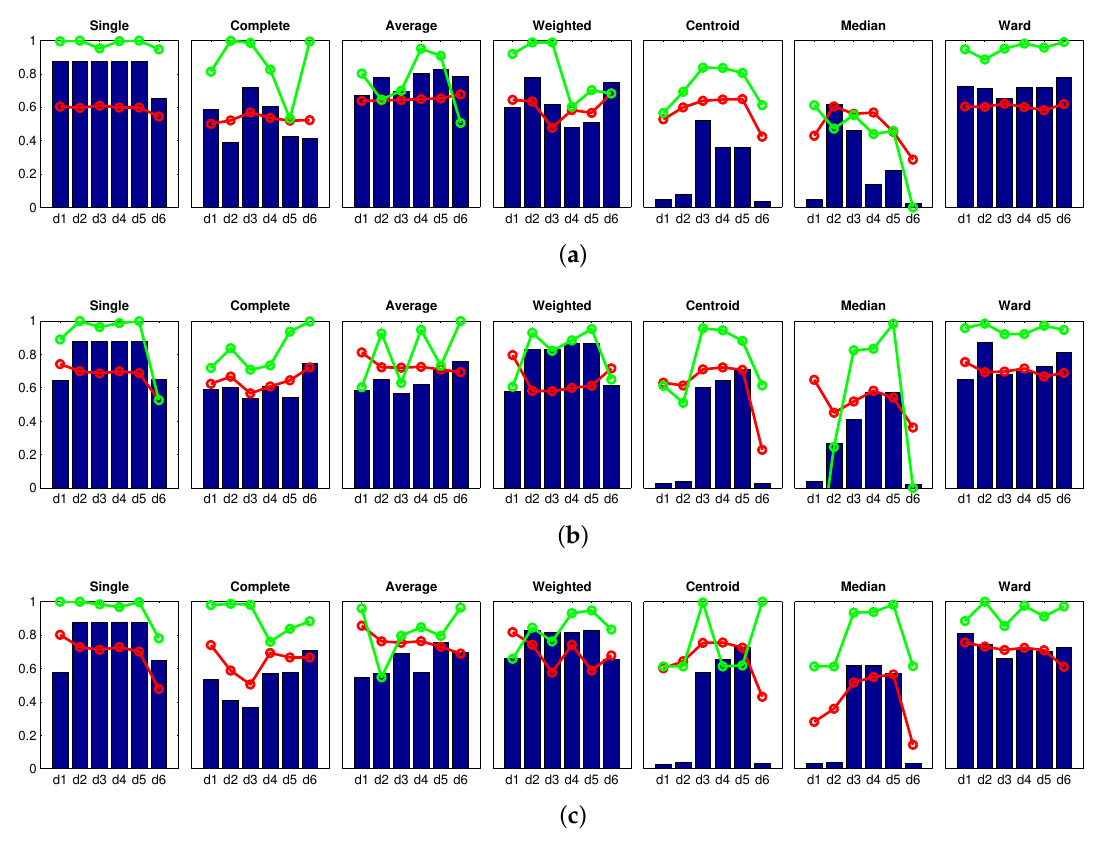
Figure 6. Legend: (cid:4) Accuracy c ; −◦− Correlation γ coph ; −◦− Inconsistency δ inconsist . Results of the high-level clustering using the Fourier signature as global-appearance descriptor and ( a ) k 1 = 8; ( b ) k 1 = 32; and ( c ) k 1 = 128. In the horizontal axes, d 1 to d 6 represent the distance